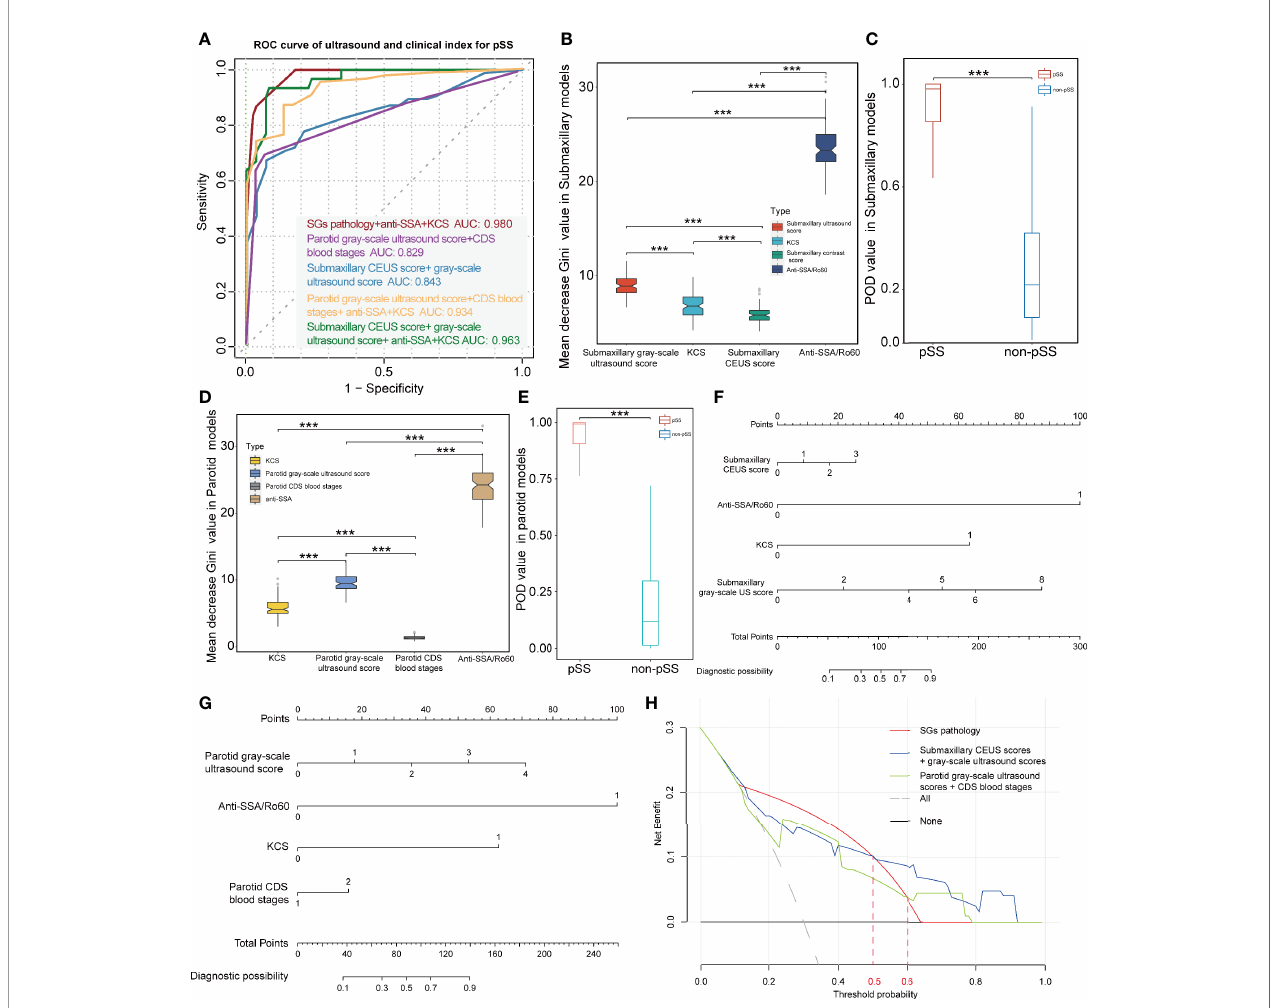
FIGURE 5 | Diagnostic capacity of ultrasonographic signatures for primary Sjögren ’ s syndrome (pSS). (A) ROC curve of pSS prediction using the random forest models; red lines indicate the diagnostic capacity of clinical indices with MSGB (AUC 0.980); purple lines indicate the diagnostic capacity of the model with parotid grayscale ultrasound score and CDS blood stages (AUC 0.829); blue lines indicate the diagnostic capacity of the model with submaxillary CEUS score and grayscale ultrasound score (AUC 0.843); yellow lines indicate the diagnostic capacity of the model combining clinical indices and parotid ultrasonographic signatures without MSGB (AUC 0.934); and green lines indicate the diagnostic capacity of the model combining clinical indices and submaxillary ultrasonographic signatures without MSGB (AUC 0.963). (B, D) Mean decrease Gini coef fi cient represents the speci fi c diagnostic capabilities of variables in the construction of the predicting model. Variable importance of ultrasonographic signatures is lower than anti-SSA/Ro60 positivity but signi fi cantly higher than KCS. (C, E) The combined models without MSGB reveal a high predictive accuracy with higher POD value for pSS in both the parotid and submandibular glands. Nomograms were developed to aid in predicting risk of pSS using the four prognostic factors in parotid (F) and submandibular glands (G) . (H) DCA reveals the threshold probability of a patient was >50%/>60%. Using submandibular/parotid ultrasonographic examination adds more net bene fi t than using pathological results of the salivary glands for the prediction of pSS. ***p <